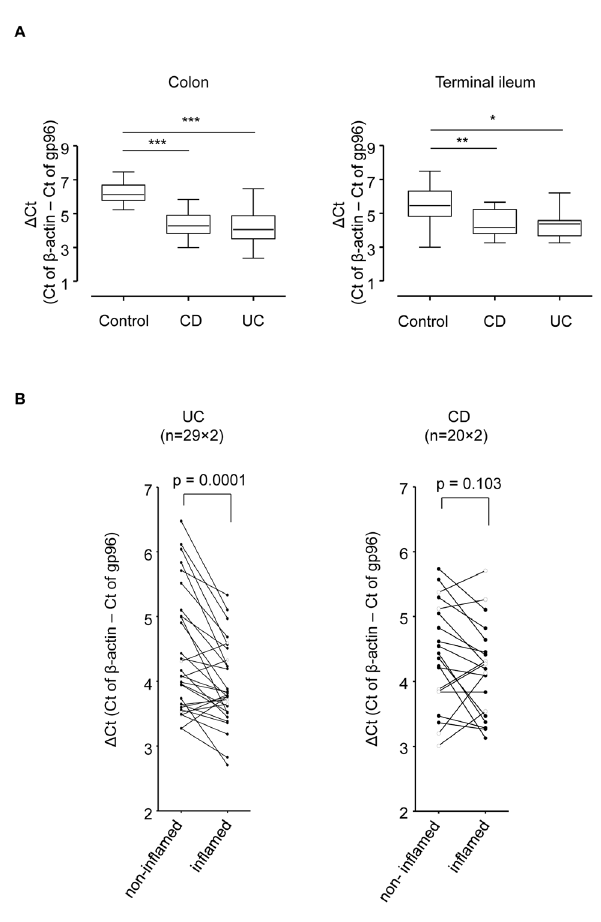
Figure 5. Analysis of gp96 mRNA in intestinal biopsies from IBD and control patients. (A) Relative mRNA levels of gp96 (vs. b - actin) in biopsies from colon and terminal ileum of control and IBD patients. (B) Paired analysis of gp96 expression levels within individual patients (involved vs. non-involved). Error bars represent standard error of the mean. * p , 0.05, ** p , 0.001, *** p , 0.0001.